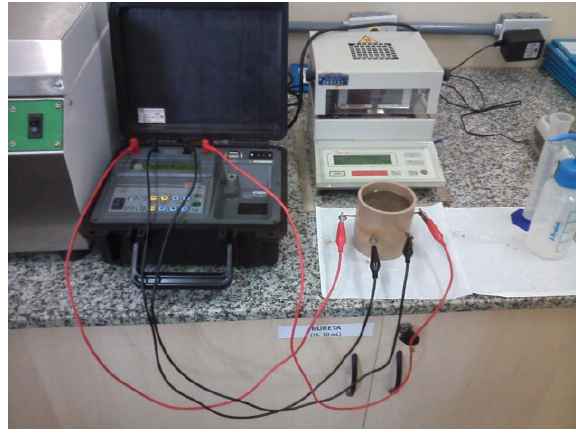
Fig. 6. Equipment for the analysis of correlation R m x w x δ .